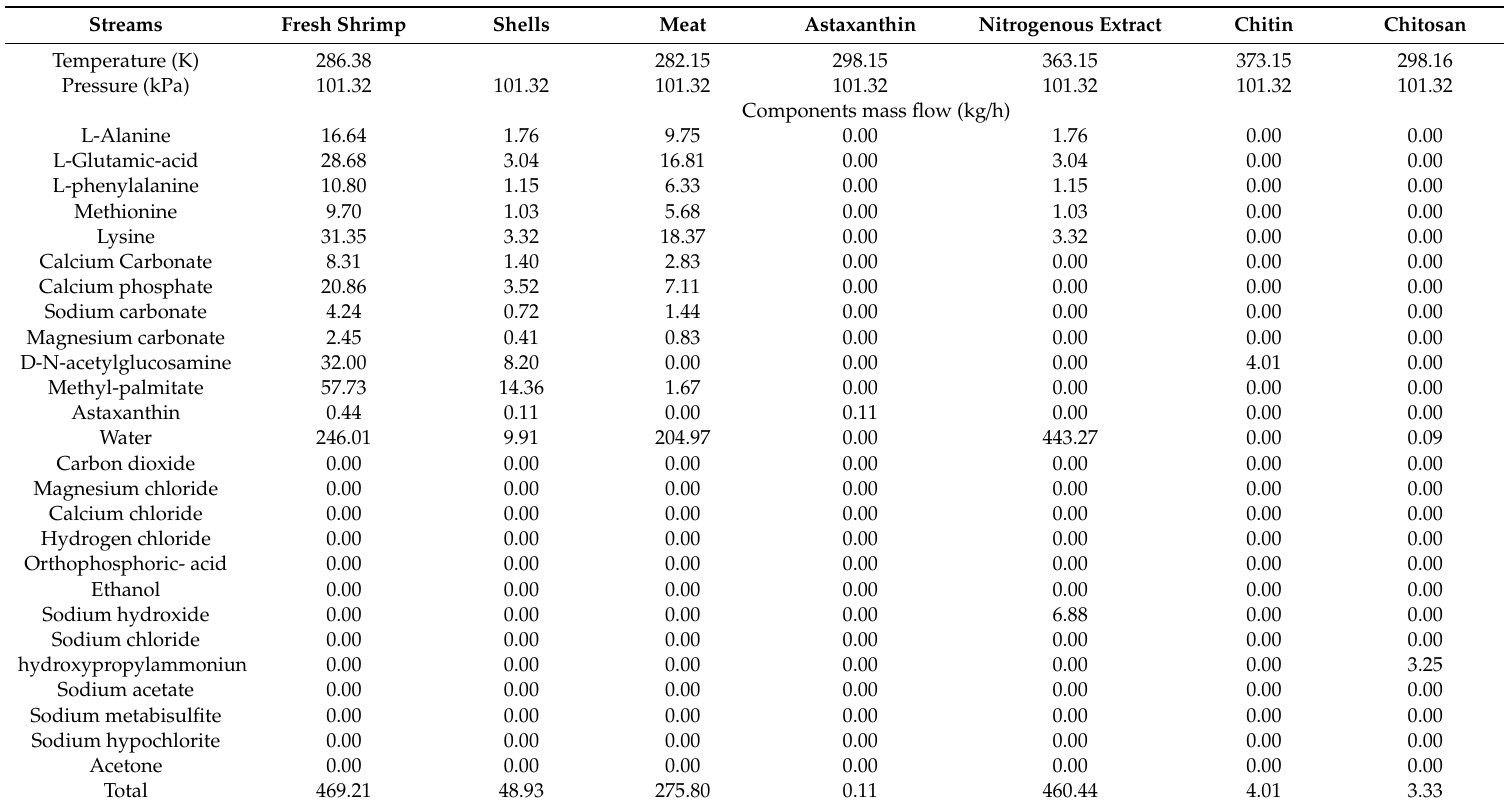
Table 1. Main process streams for mass-integrated biorefinery based on